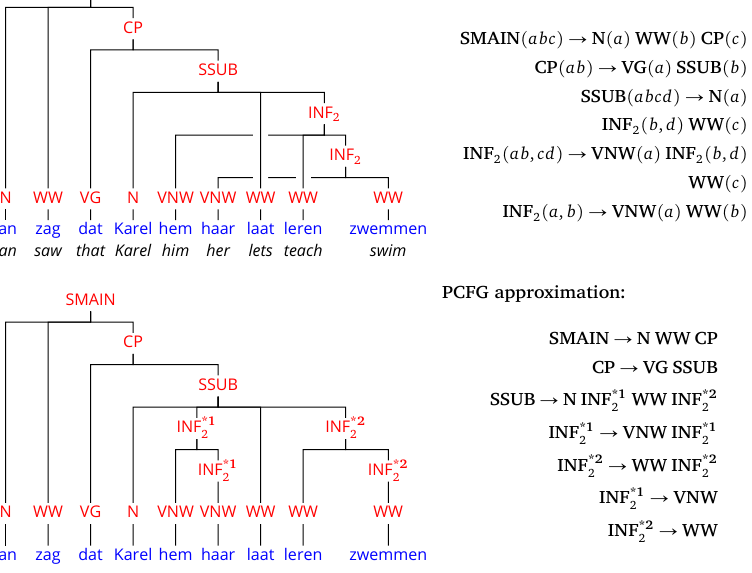
Figure 10: Cross-serial dependencies in Dutch expressed with discontinuous con- stituents (top); and the same parse tree, after discontinuities have been encoded in node labels